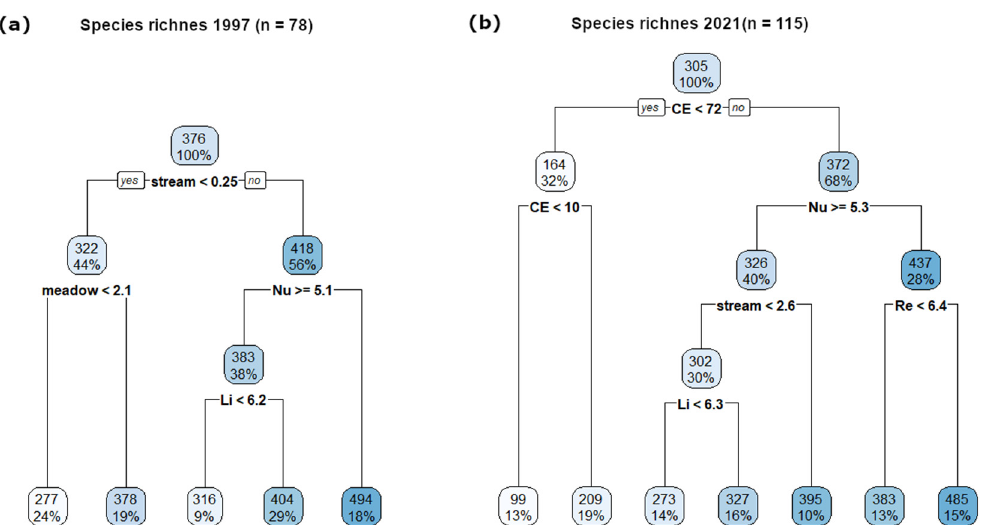
Figure 6. The regression trees for species richness in surveys in ( a ) 1997 (n = 78) and ( b ) 2021 (n = 115) based on the proportions (%) of individual land-cover categories per grid cells, landscape het- erogeneity and proportions (%) of individual NPs and surrounding area, resp. surveyed area per grid cells (CE; within 2021). Numbers in each node represent the average of species richness in this node.